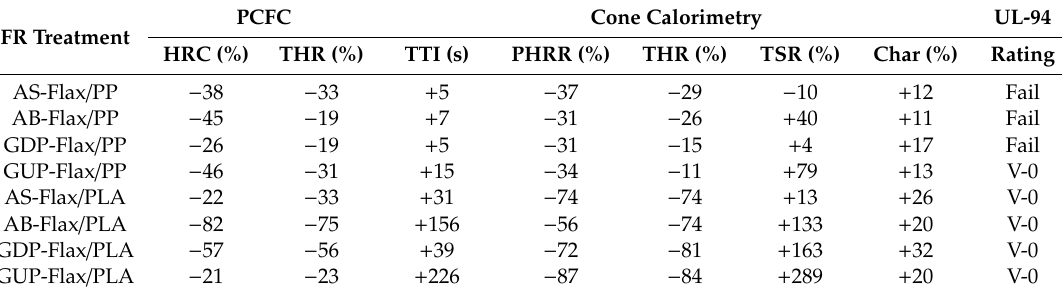
Table 3. Percentage change in flammability parameters w.r.t those of the respective control samples.